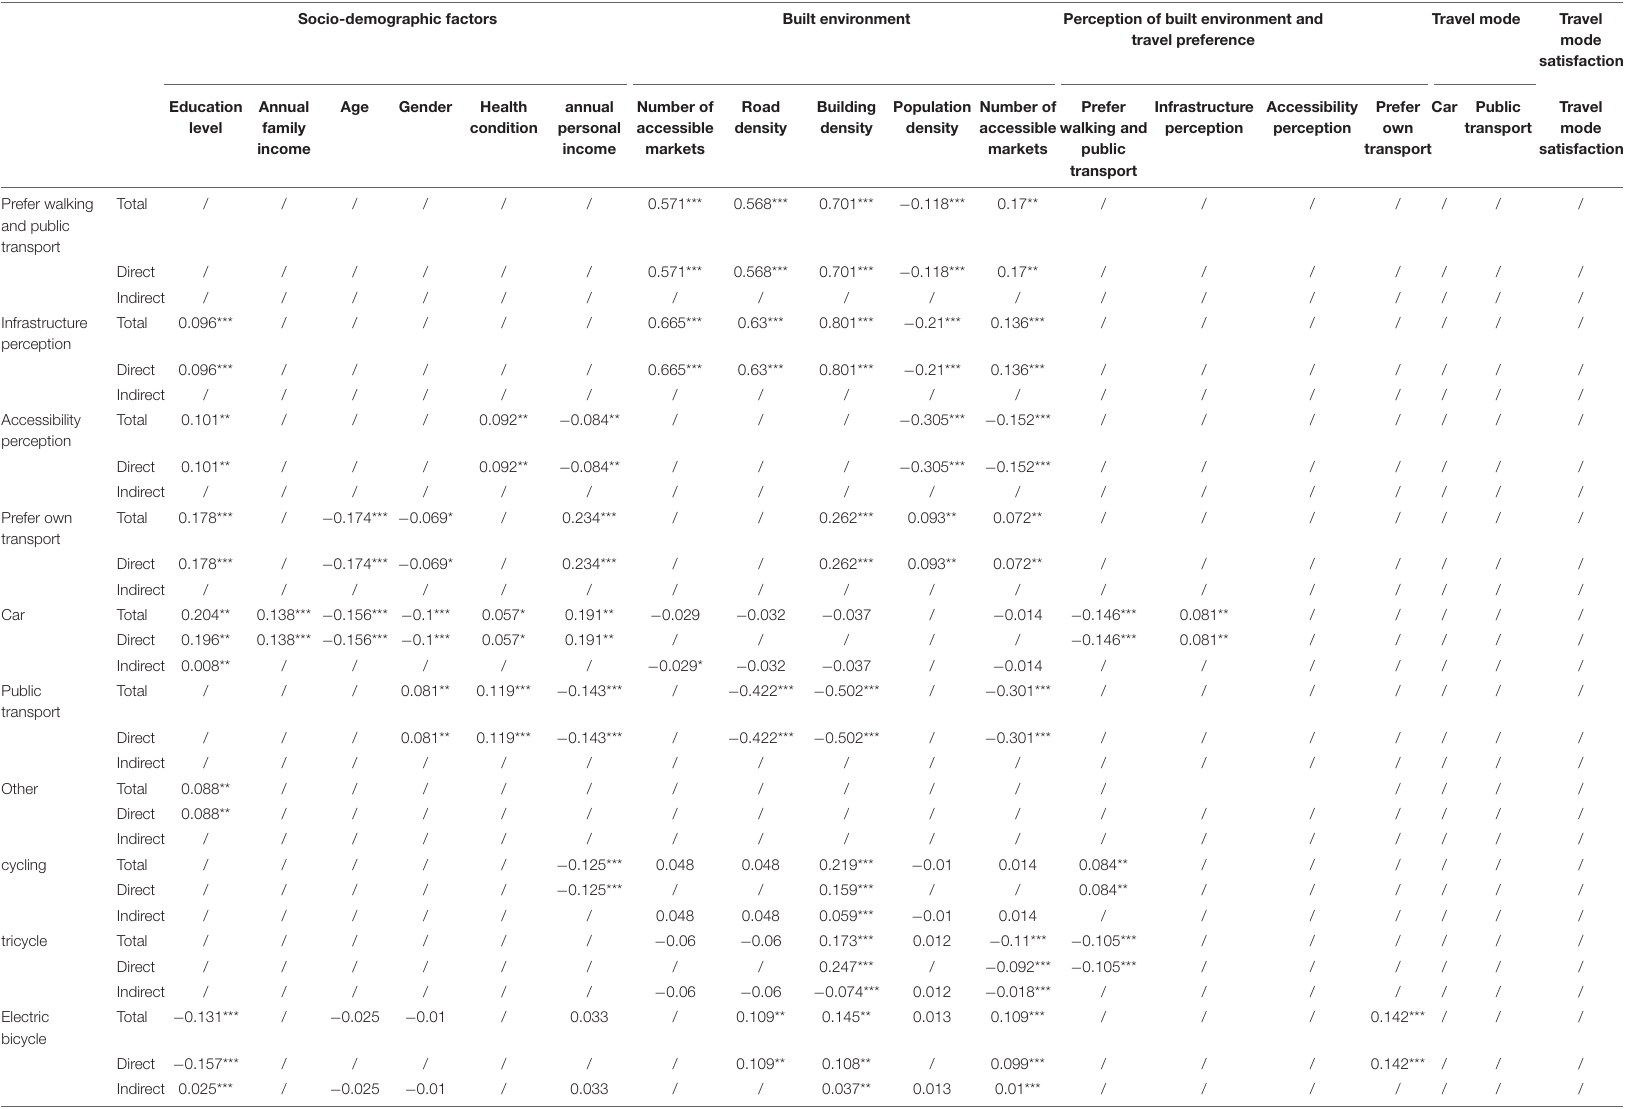
TABLE 9 | Direct, indirect, and total impacts among